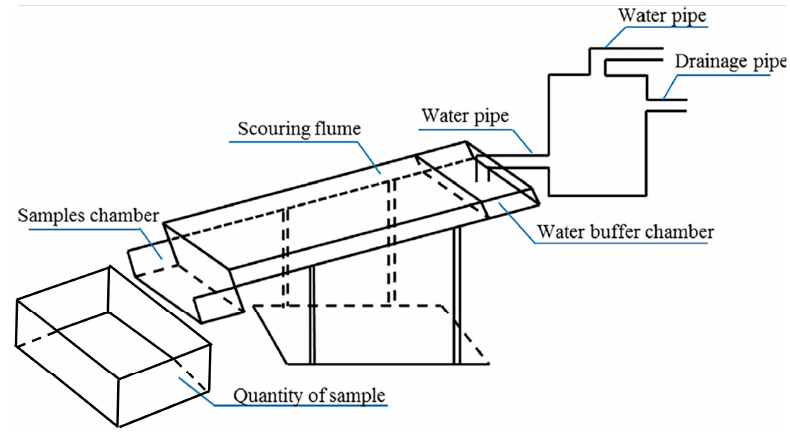
Figure 4. Setup for SRS test.